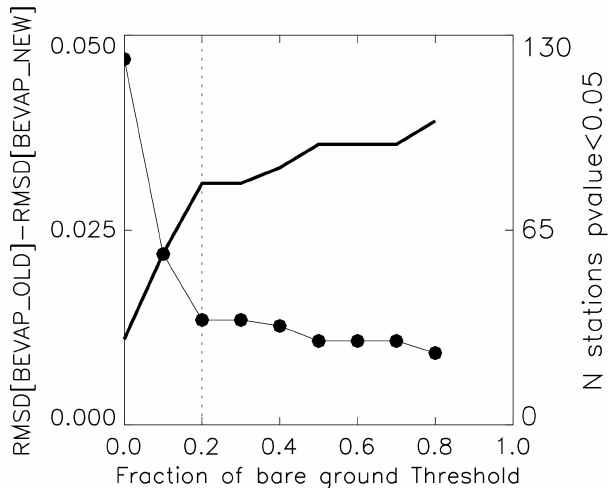
Fig. 3. Soil moisture RMSD between BEVAP OLD and BE- VAP NEW as a function of the fraction of bare ground (black solid curve, left y-axis), the number of in situ stations used (for which significant correlation is obtained between observations and model time-series) is also presented (black dots, right y-axis). The dashed line represents a bare soil fraction threshold below which the sen- sitivity of soil moisture to the new evaporation formulation is less pronounced.